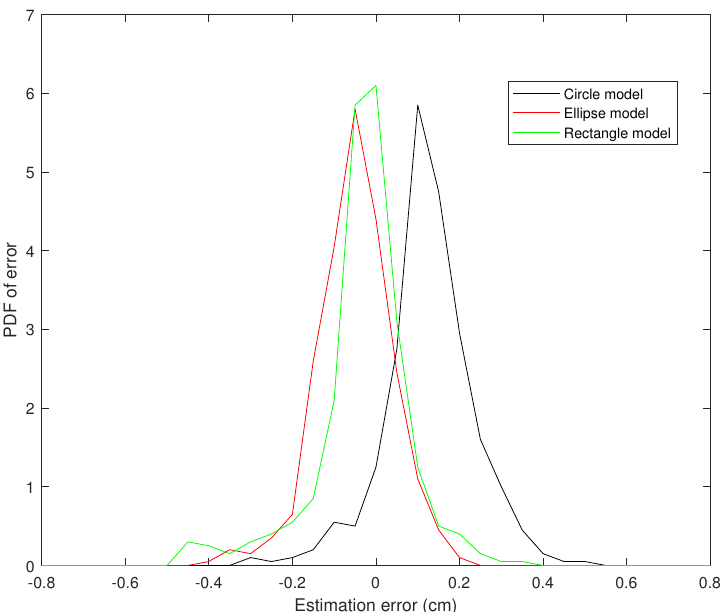
Figure 10. PDF of the AP-diameter estimation error w.r.t. manual measurement for the second sample video depicted in Figure 5, as measured by active circle algorithm (black line), active ellipse algorithm (red line) and active rectangle algorithm (green